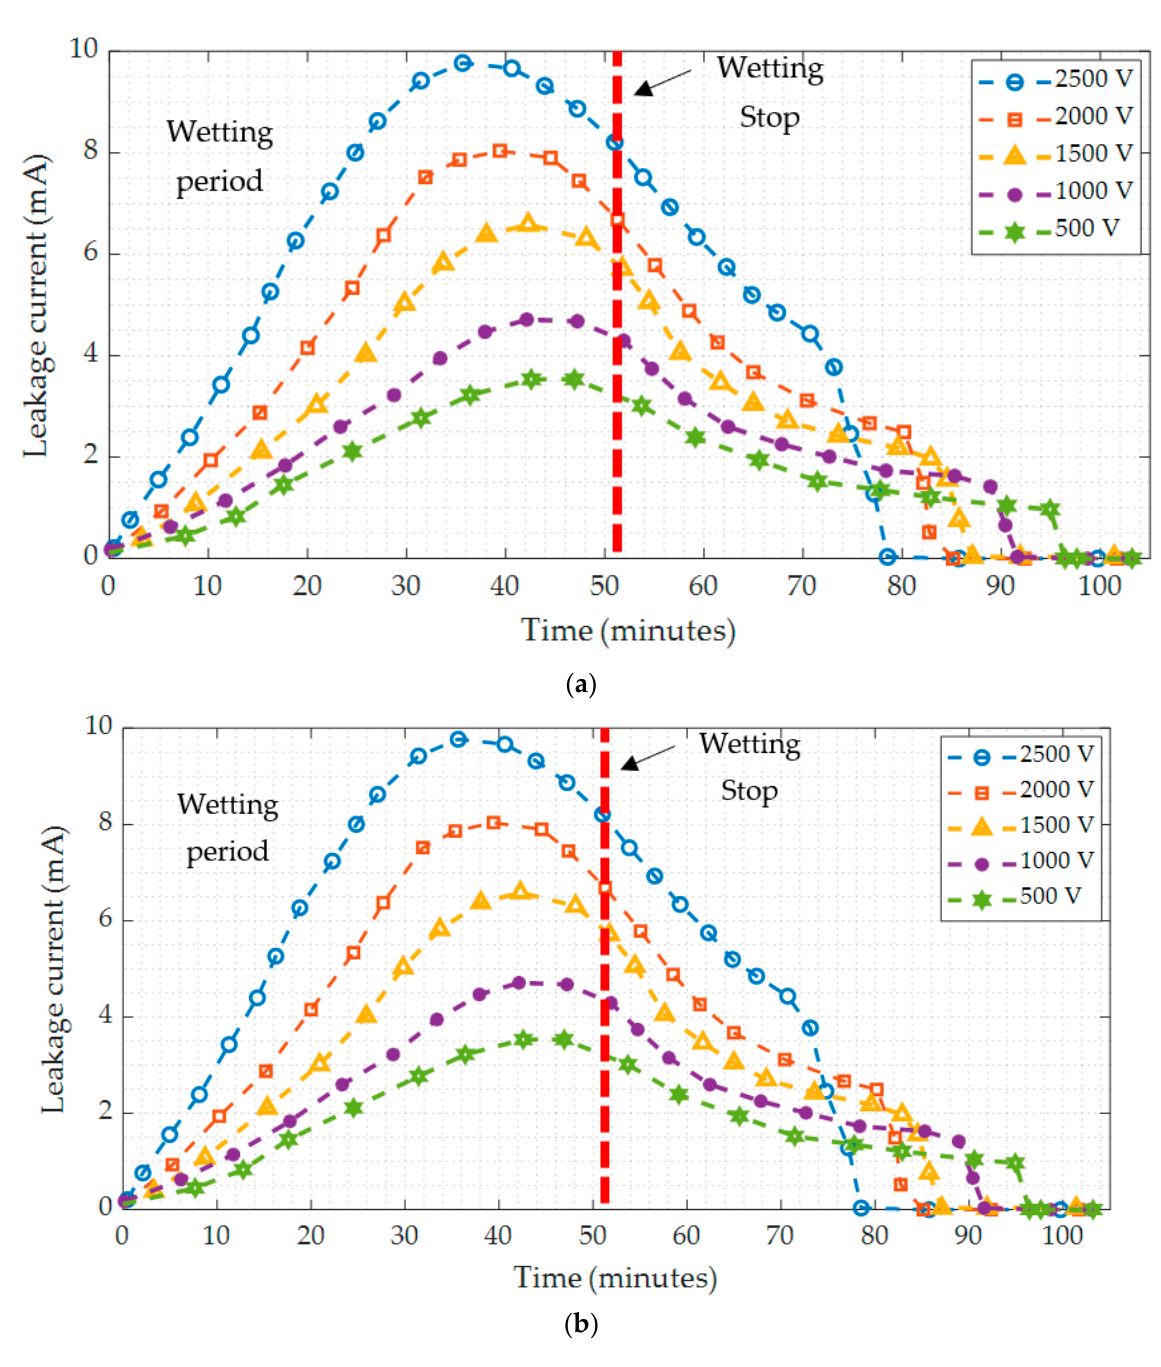
Figure 5. Leakage current of ( a ) insulator type I; ( b ) insulator type II under various applied voltages.